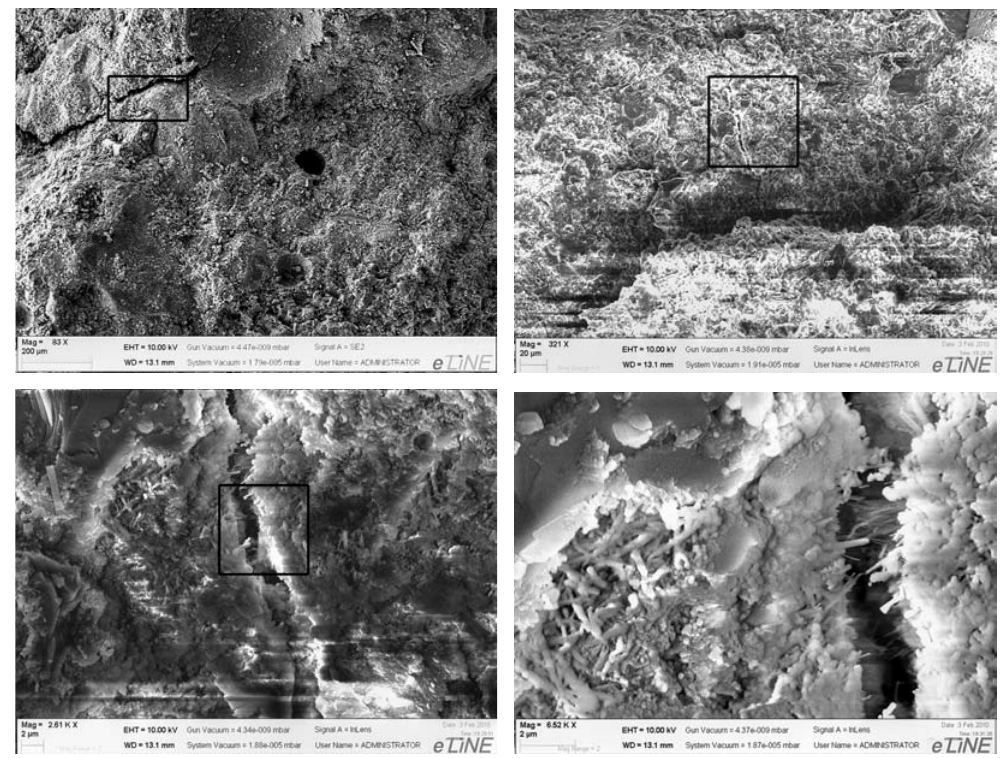
Fig. 9 . The structure of D1 series concrete cubes